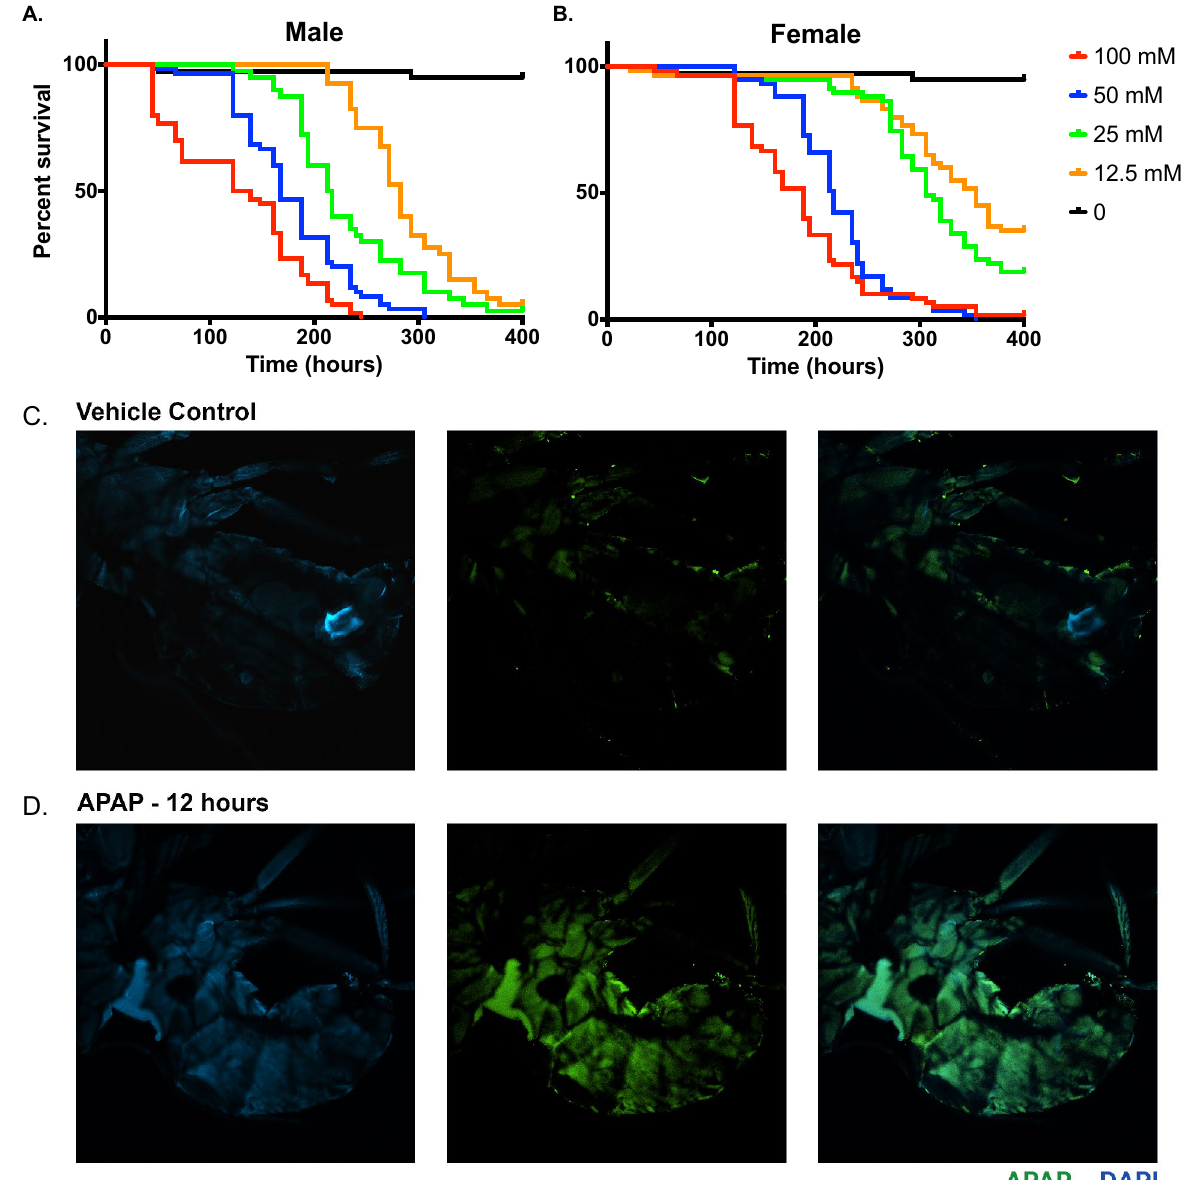
Figure 1. Acetaminophen toxicity and accumulation in adult Drosophila . Mortality observed due to APAP exposure in 5-day old w 1118 ( A ) male and ( B ) female Drosophila . Log-Rank p = 0.0001, n = 60. CLARITY staining for DAPI and anti-APAP antibodies in Drosophila treated for 12 h with ( C ) vehicle and ( D )